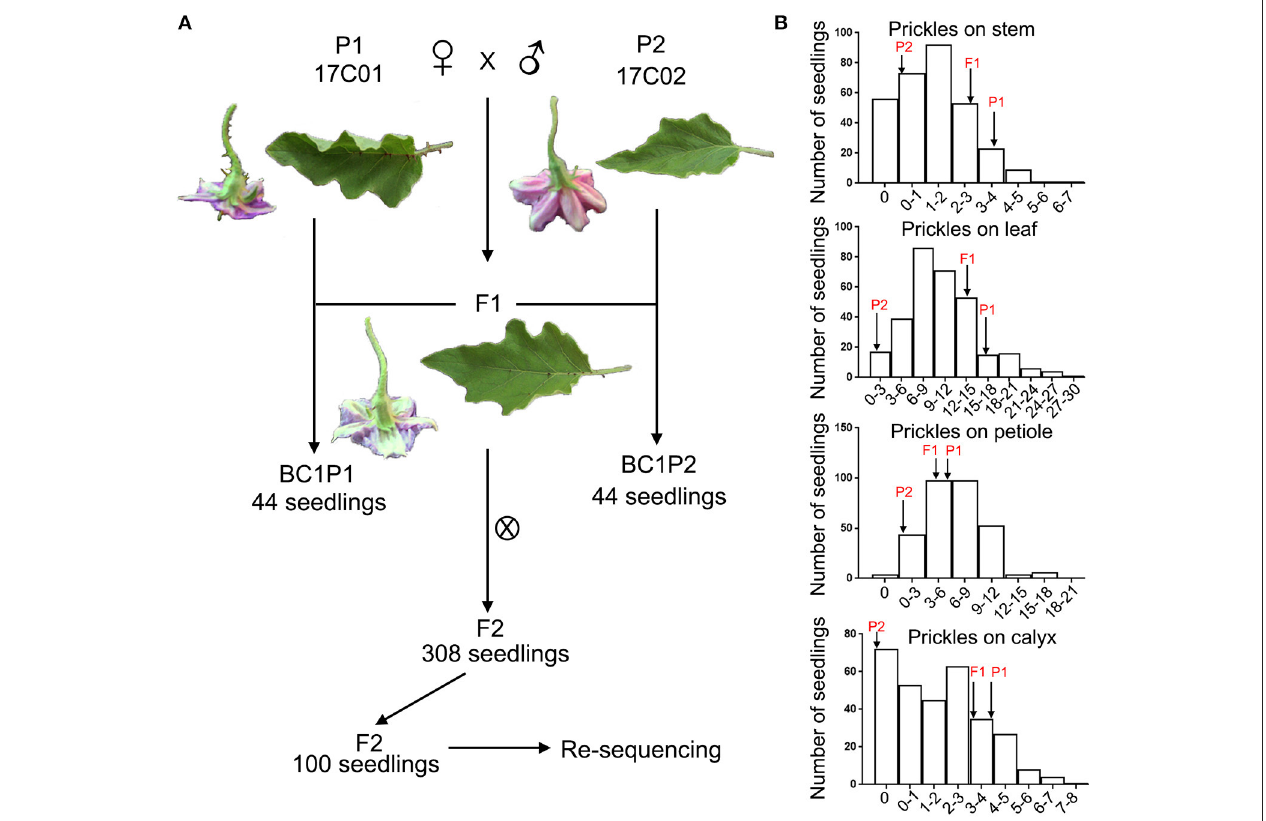
FIGURE 2 | The construction of segregating populations and the distribution of prickles on stem, leaf, petiole, and calyx in these populations. (A) The construction of F1, F2, BC1P1, and BC1P2 populations. (B) Frequency distribution of the numbers of prickles on the stem, leaf, petiole, and calyx in the F2 population. Arrows indicate the prickle numbers of two parents, 17C01 and 17C02, and the F1